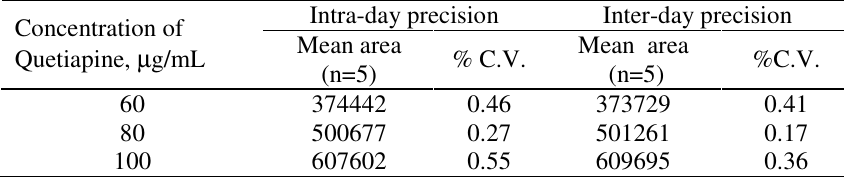
Table 4. Precision of the proposed HPLC